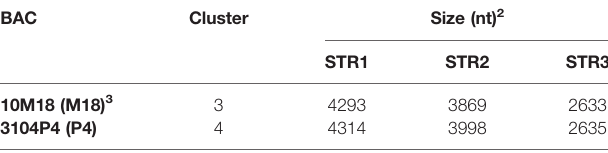
TABLE 1 | The second STR island in Locus 2 alleles are different lengths 1